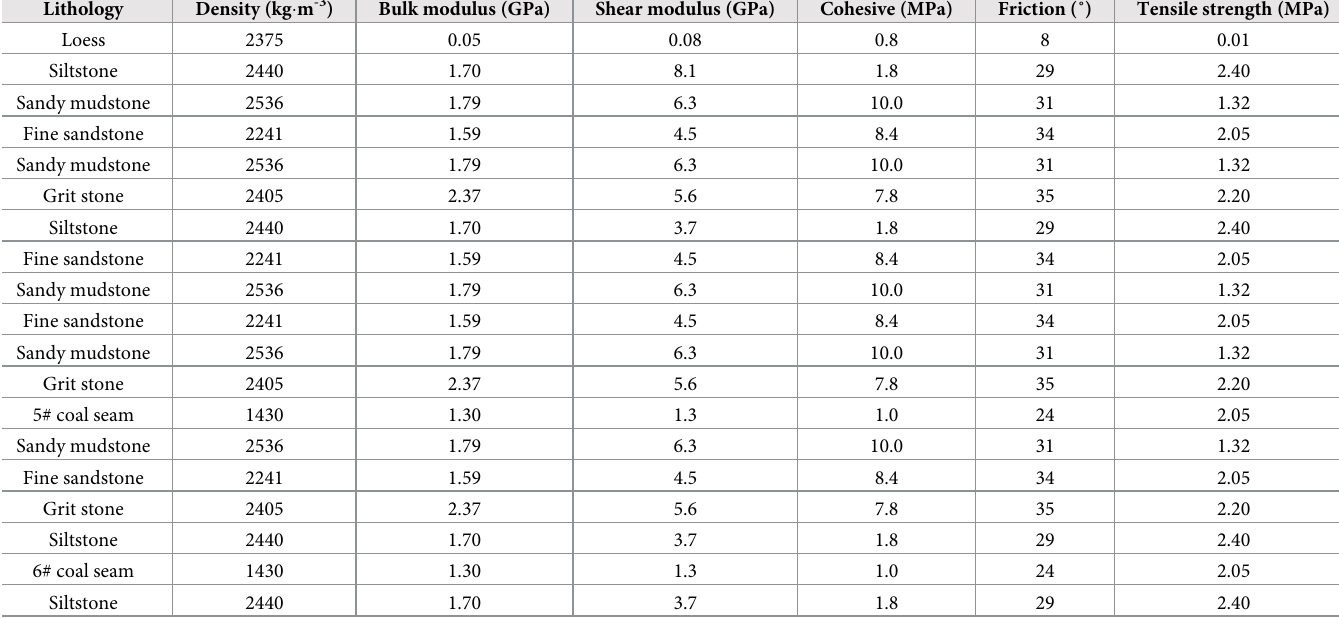
Table 3. Mechanical parameters of coal and rock block.